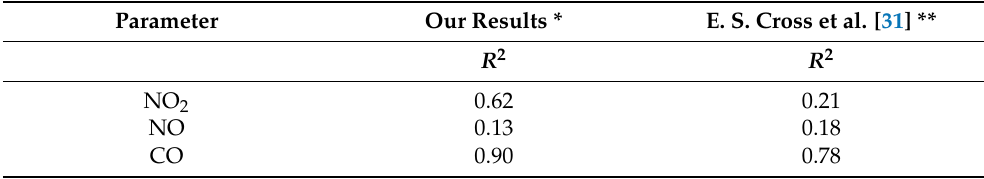
Table 10. Comparison of